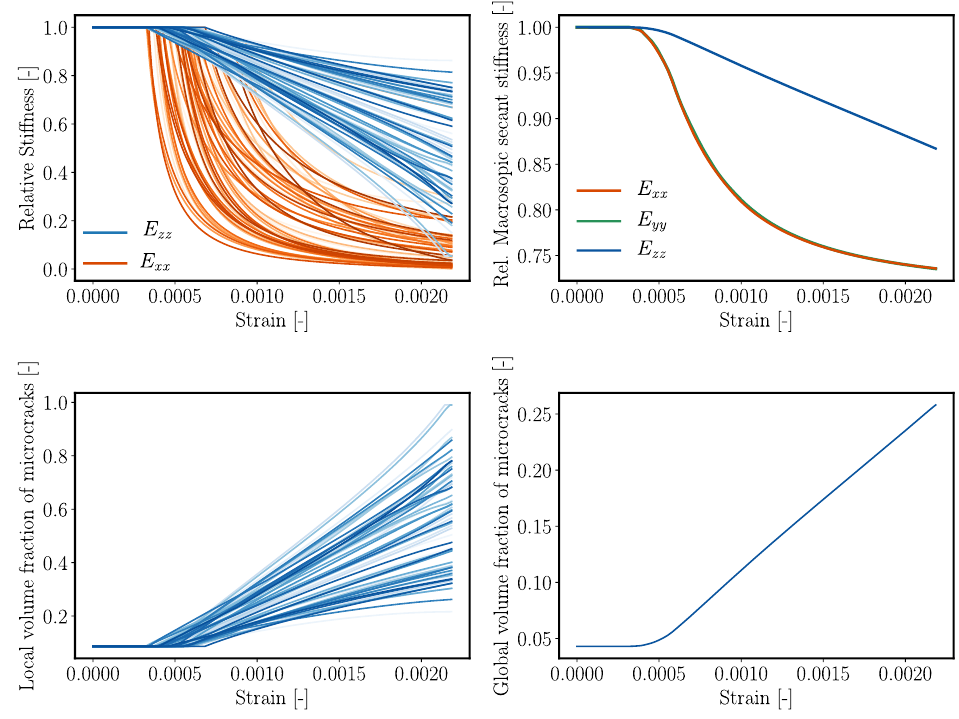
Figure 15. Top left: relative stiffness evolution under uniaxial compression of all mortar clusters in x - and z -directions. Top right: relative macroscopic secant stiffness of concrete under uniaxial compression at macroscopic scale. Bottom: volume fraction of microcracks, in all mortar clusters (left), and total volume fraction of microcrack in concrete samples